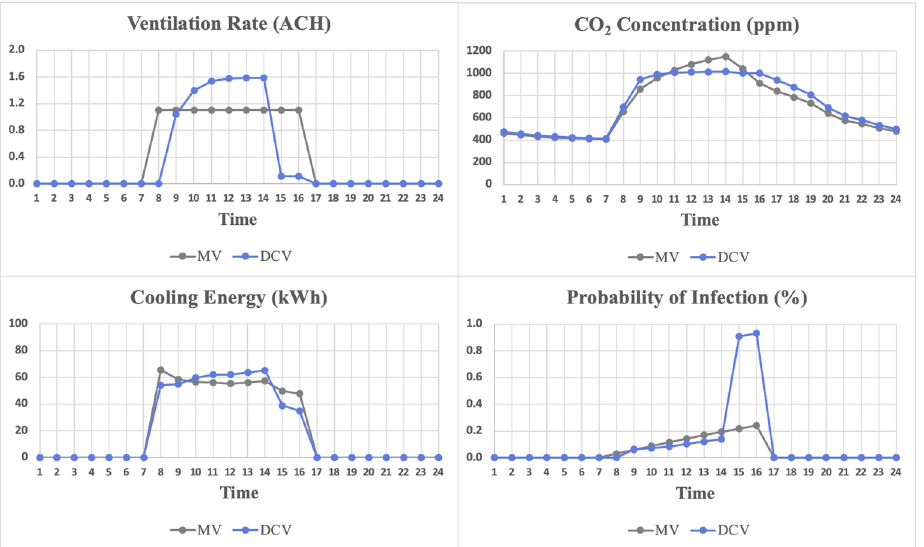
Figure 6. Hourly variations in ACH, CO 2 concentration, cooling energy use, and POI for both MV and DCV during 22 July.